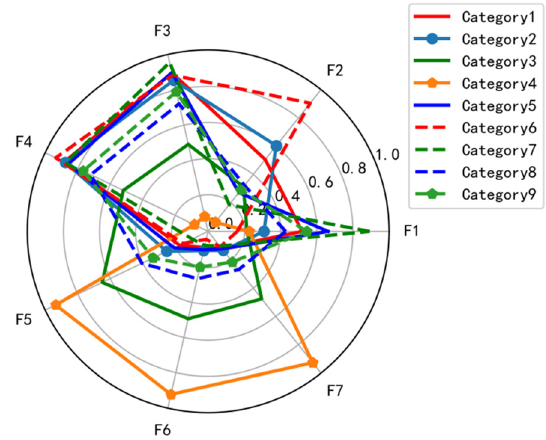
Figure 5. Cluster centers of nine cluster categories.